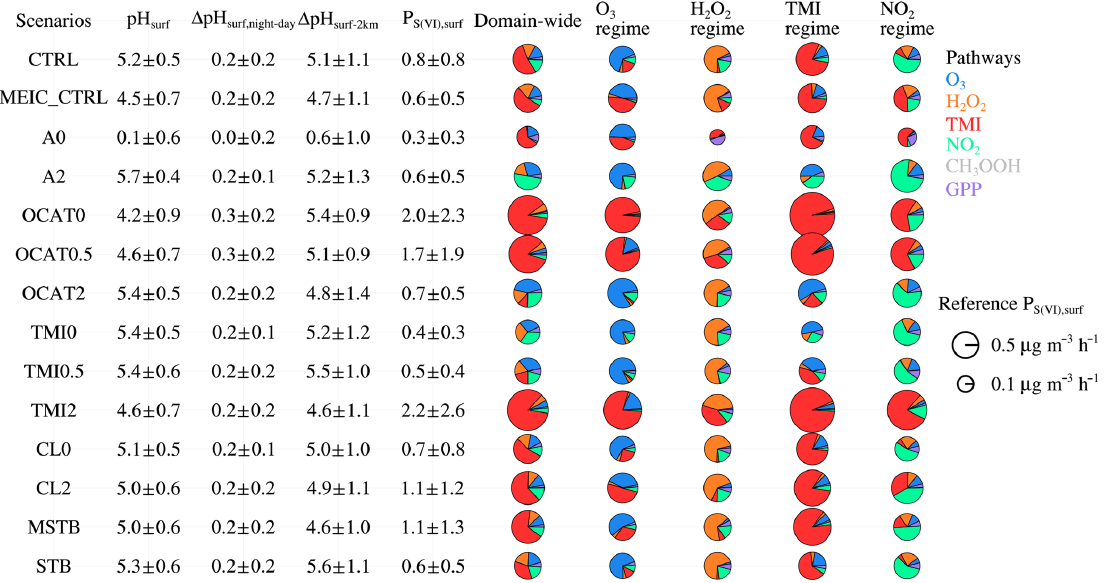
Figure 9. Surface layer pH (denoted as pH surf ) and its day–night difference (denoted as (cid:49) pH surf,night-day ), the difference between surface layer pH and pH at ∼ 2kma.g.l. (denoted as (cid:49) pH surf-2km ), and surface layer sulfate production rates (denoted as P S(VI),surf ) for the domain- wide grid cells south of 41 ◦ N in the control and sensitivity experiments during January 2013. Contributions from different sulfate formation pathways over the domain-wide grid cells south of 41 ◦ N and the four dominant sulfate formation regimes (O 3 , H 2 O 2 , TMI and NO 2 , respectively, as defined in Fig. 8a) are also shown in pie charts. The radius R for the pie chart is scaled depending on the sulfate production rate P using R/R ref = 2exp ( log10 (P/P ref ))